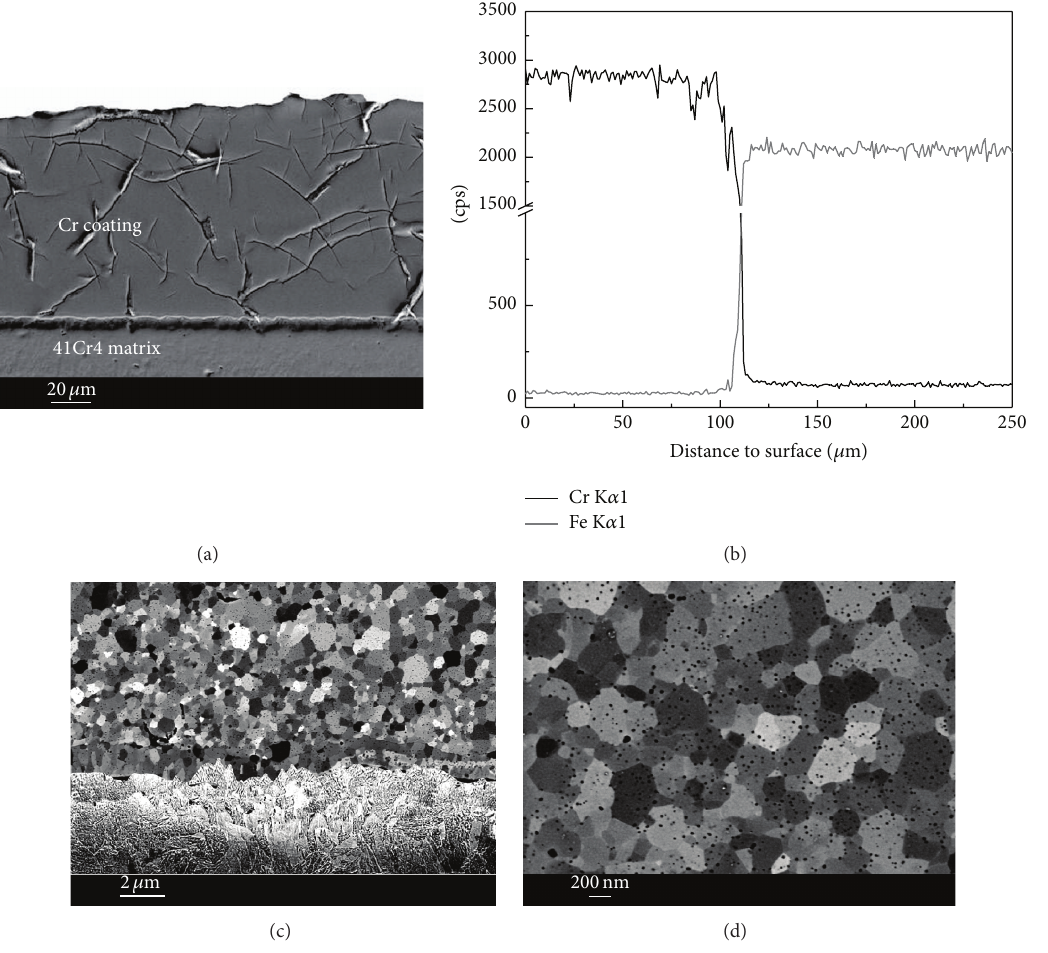
Figure 2: Sectional view of microstructure of the sample surface: (a) SEI image, (b) line scanning of EDS, (c) BSEI image, and (d) high magnification BSEI showing nanocrystalline